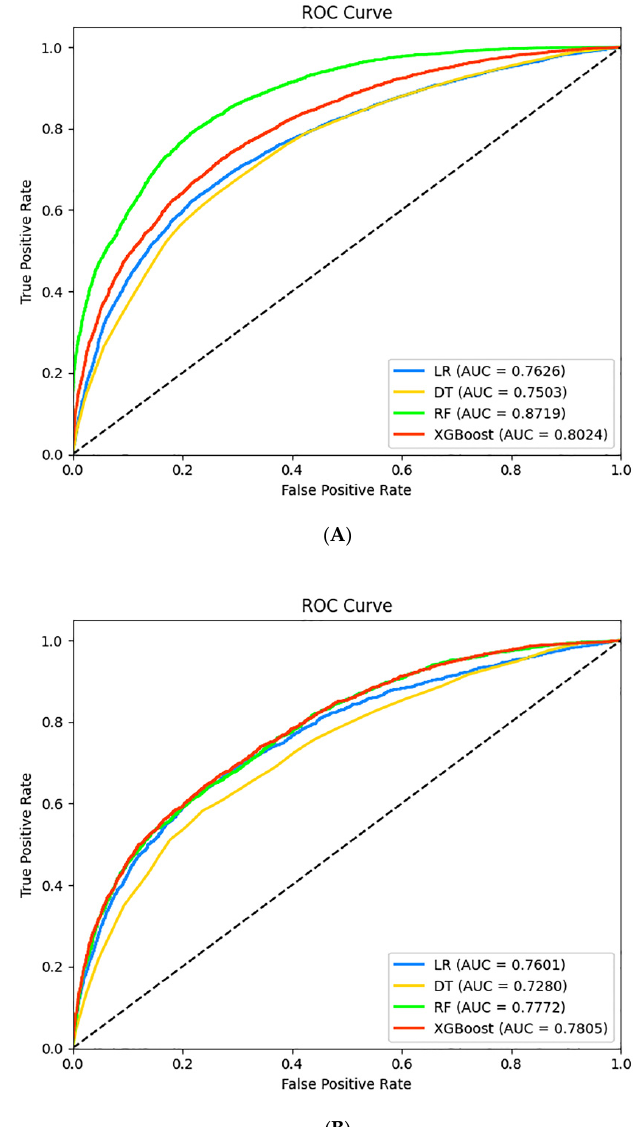
Figure 2. The receiver operating characteristics (ROC) curves of the four machine learning models on the training set ( A ) and test set ( B ).